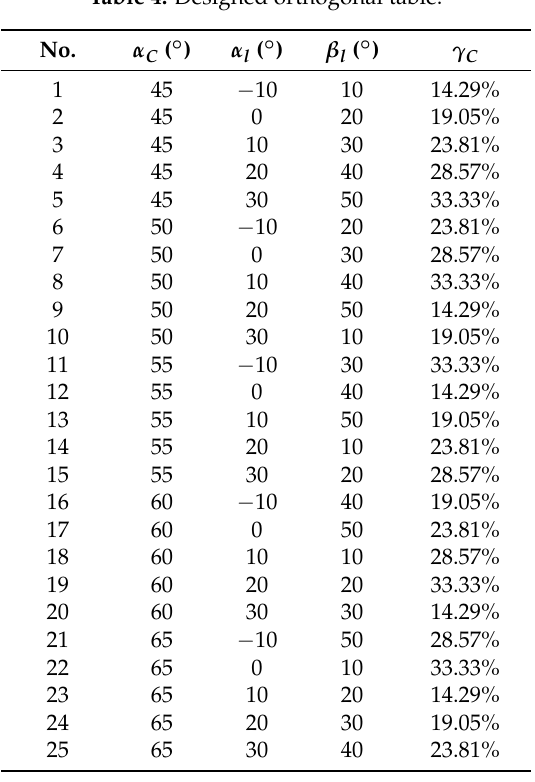
Table 4. Designed orthogonal